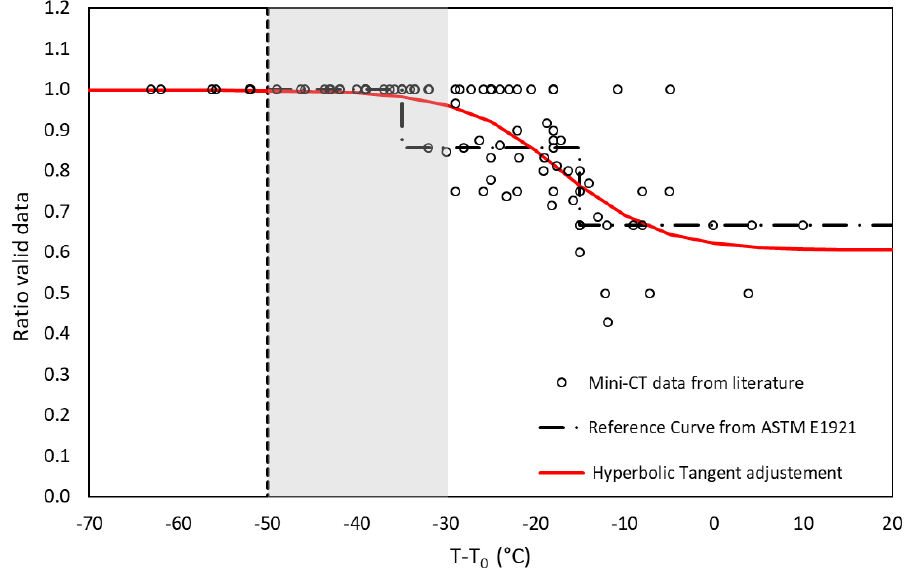
Figure 3. Relation between the ratio of valid data vs. (T − T 0 ) for mini-C(T) specimen. T is the testing temperature. Data from: [7 – 9,12 – 14,22,23,26,29 – 34].